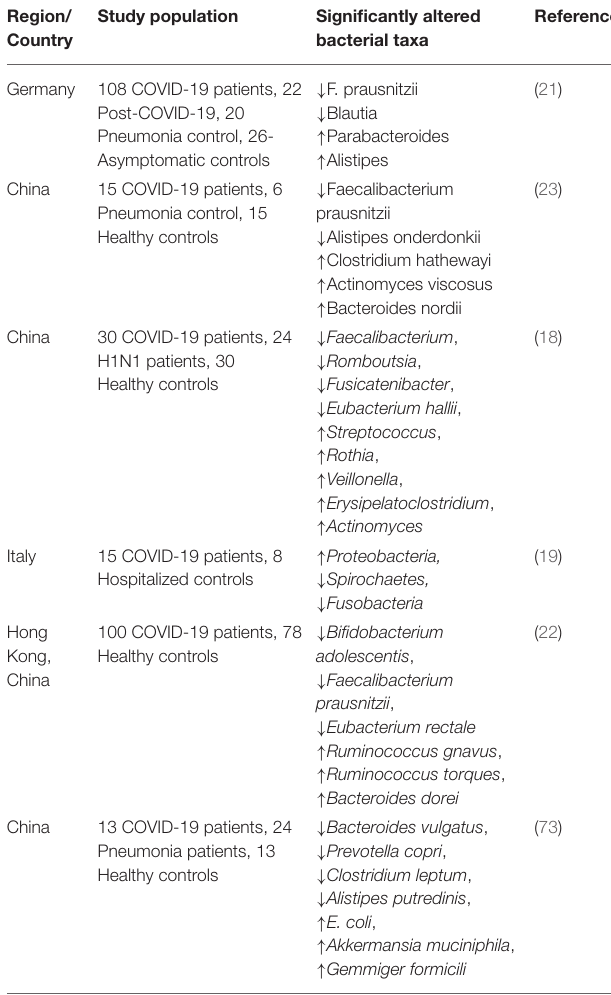
TABLE 1 | Summary of studies exploring SARS-CoV-2 infection associated alteration in the gut microbiome. Region/ Study population Significantly altered Country bacterial